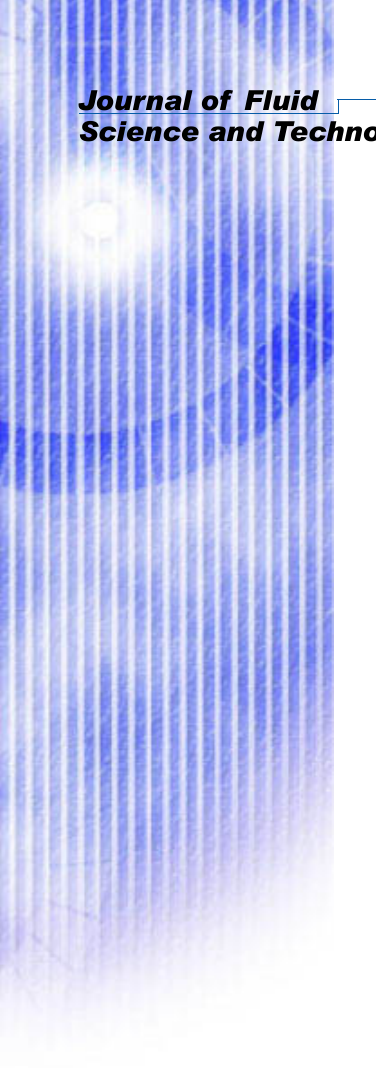
For the intermediate cavitation type, the upstream static pressure increases exponentially with the occurrence of a cavitation. After that, the upstream static pressure decreases and tends toward a stable value in the cavitating flow. In addition, the volumetric flow rate reaches a peaked value exponentially and closes in on a stable value. The stable value of the upstream static pressure exhibits almost the same tendency toward the volumetric flow rate compared with the continuous cavitation type. After that, the static pressure in the upstream decreases and the volumetric flow rate increases as the cavitation disappears. The peak amplitude of the static pressure seems to be the largest for this cavitation